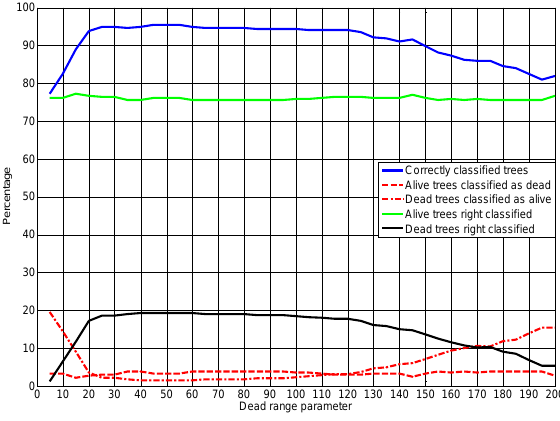
Figure 9. Classification percentages obtained for the different dead range parameter values for the light curtain